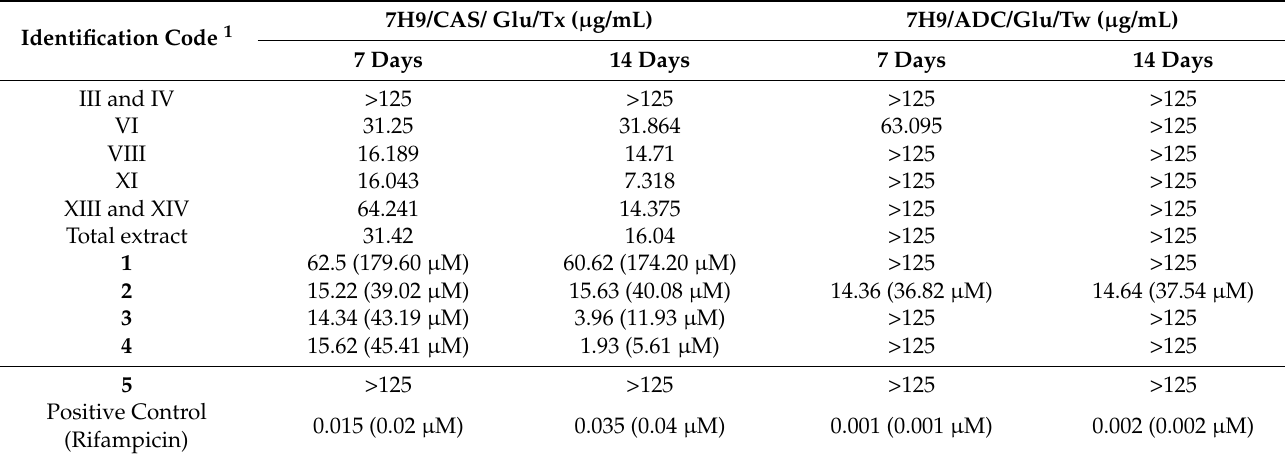
Table 3. The antimycobacterial activities of the isolated compounds at 90% inhibition in 7H9/ADC/Glu/Tw and 7H9/CAS/ Glu/Tx media.